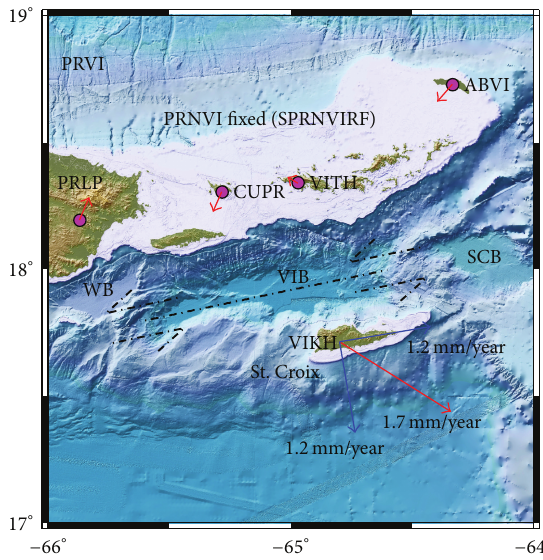
Figure 5: An interpretation of the overall faulting within the Virgin Islands basin (VIB). The dark dash-dot line within the Virgin Islands basin does not represent any specific fault. It just depicts the direction of the long-axis of the